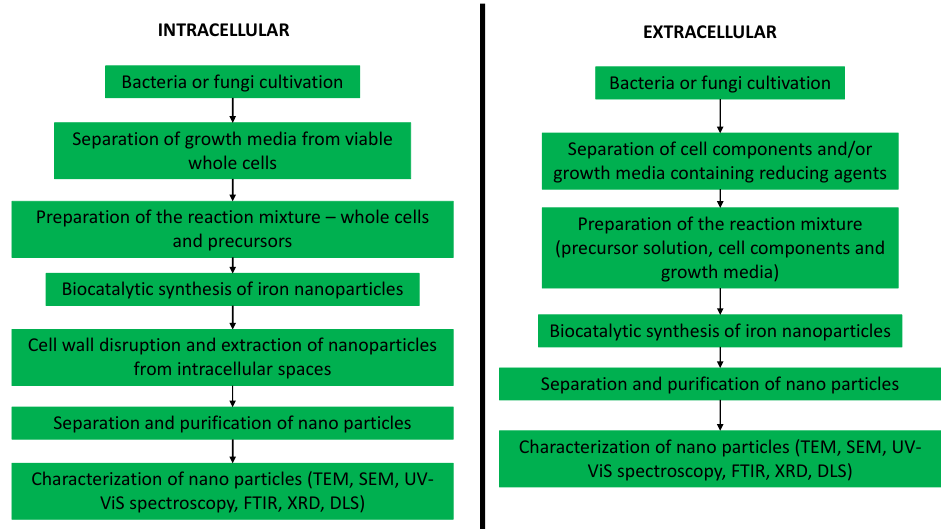
Figure 3. Flowchart of iron nanoparticle synthesis using bacteria and fungi.